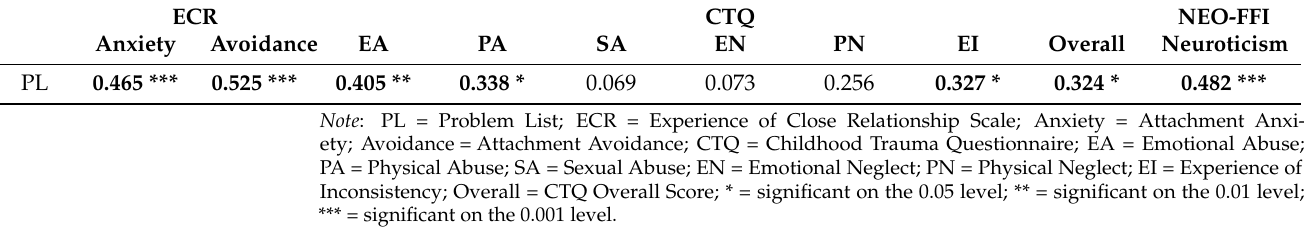
Table 5. Correlational Analysis between Relationship Problems and Predispositioning Factors, across the Entire Sample. ECR CTQ NEO-FFI